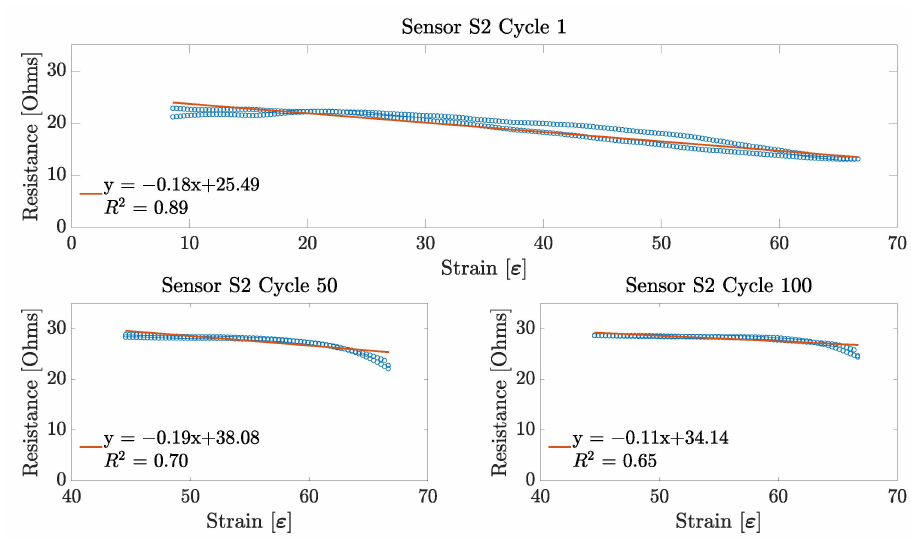
Figure 13. Linearity results for Sensor S2. Linearity data from Cycle 1 are shown over a 7.5–66% work- ing range, whereas linearity data from Cycles 50 and 100 are shown over a 40–66% working range.